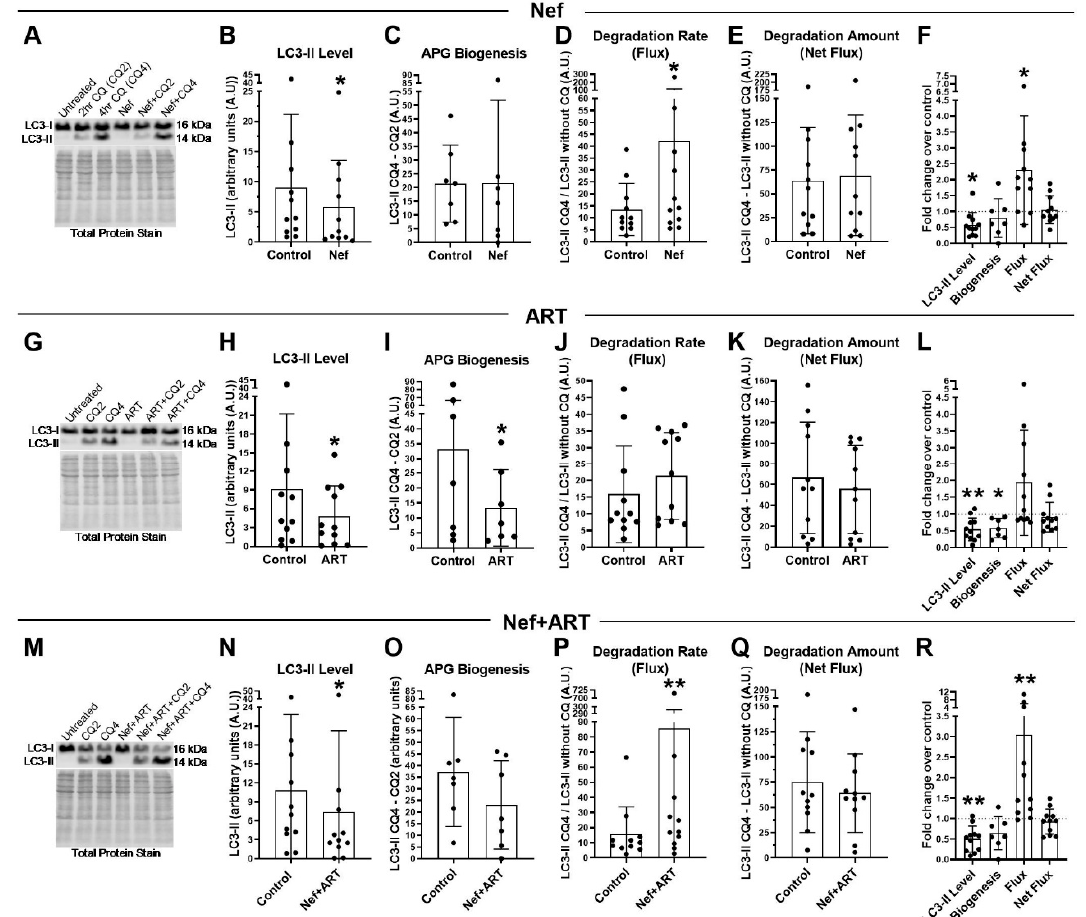
Figure 1. LC3-II steady-state level, autophagosome (APG) biogenesis and APG degradation after treatment with Nef and/or antiretroviral therapy (ART) for 24 h. Primary human astrocytes were treated daily for 7 days with extracellular Nef and/or ART, without and with chloroquine (CQ) for the last 2 or 4 h, and then LC3 Western blotting was performed. Steady-state level, biogenesis, flux and net flux for LC3-II were calculated as described in Methods. ( A , G , M ) Representative LC3-II Western blots after A. Nef, G. ART, or M. Nef+ART treatment. B–E, H–K, and N–Q show individual experiments (dots) and the means of the experiments (bars). ( B , H , N ) LC3-II steady-state level in control and B. Nef, H. ART, or N. Nef+ART treated astrocytes. ( C , I , O ) APG biogenesis in control and C. Nef, I. ART, or O. Nef+ART treated cells. ( D , J , P ) Rate of APG degradation (Flux) in control and D. Nef, J. ART, P. Nef+ART treated astrocytes. ( E , K , Q ) Amount of APG degradation (net flux) in control and E. Nef, K. ART, or Q. Nef+ART treated cells. ( F , L , R ) show the fold changes of the same autophagy parameters after treatment with F. Nef, L. ART, and R. Nef+ART over controls of individual experiments (dots) and the means of the fold changes of the experiments (bars). Controls were set to 1, represented by the dashed lines. Error bars depict SD. n = 7–11; *, p < 0.05; **, p < 0.005 by the Wilcoxon Matched-Pairs Signed Rank test or the Wilcoxon Signed Rank test.